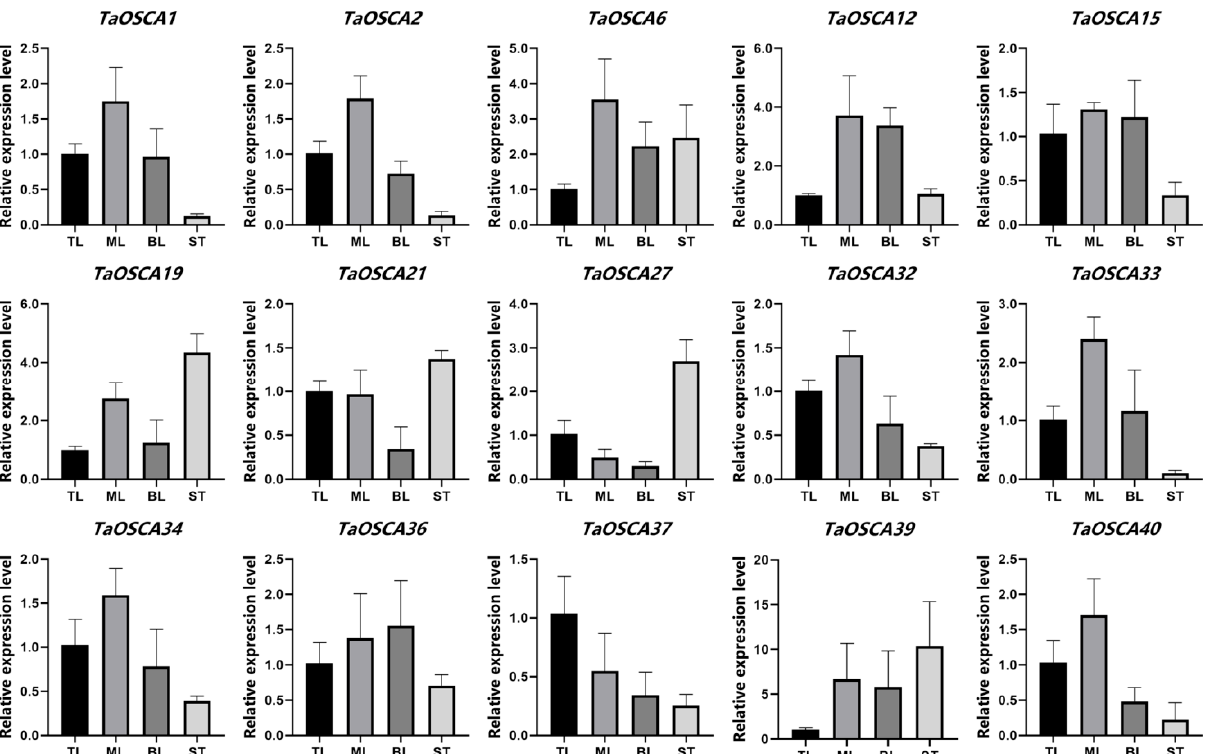
Figure 5. Expression levels of TaOSCAs in different tissues. The mean expression values were calculated from three independent biological replicates relative to that in top leaves. TL: top leaf; MF: middle leaf; BF: bottom leaf; ST: stem.